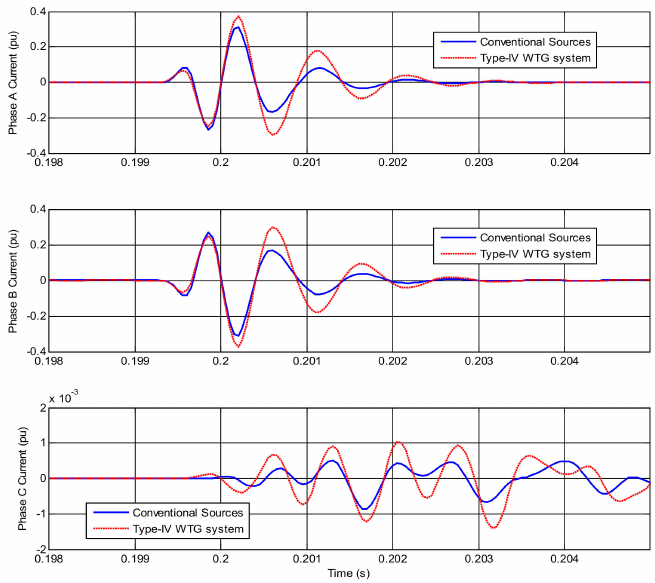
Figure 6. Band-pass filtered phase currents for an AB fault at 5% of the line with a conventional source and a Type IV WTG